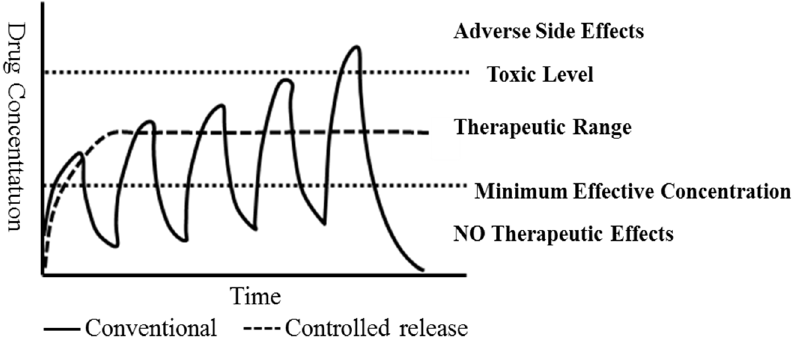
Figure 1. Drug of controlled release and dosage of tradition.